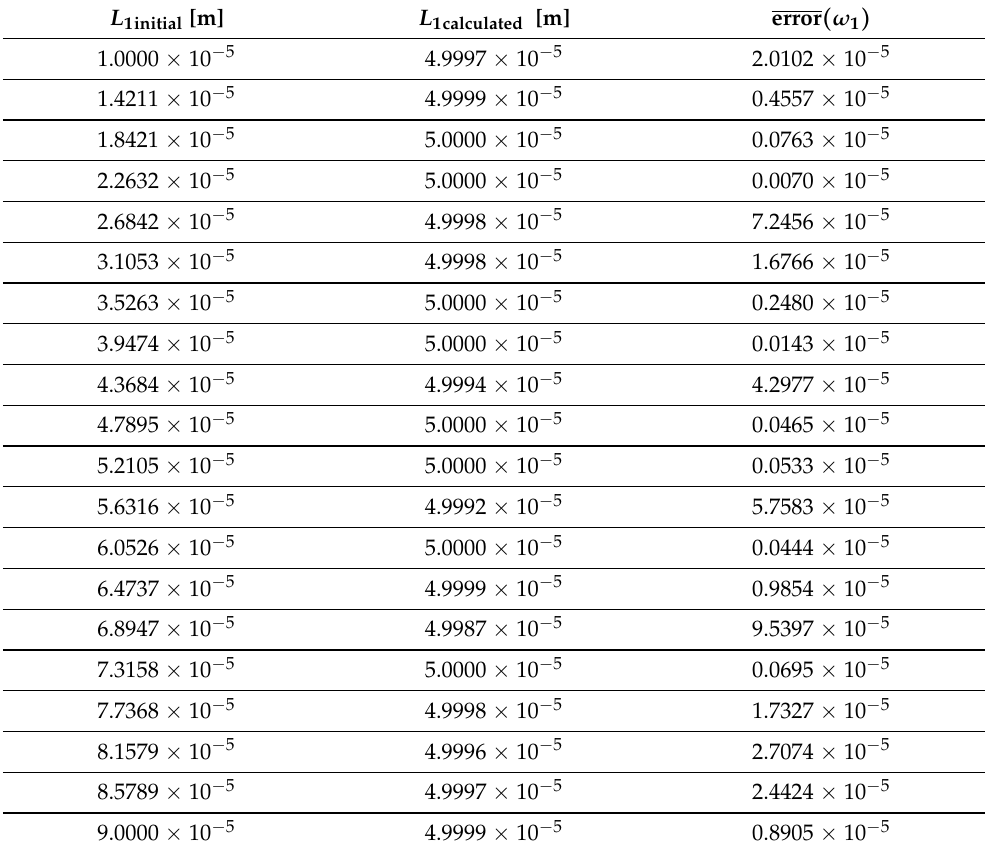
Table 4. Results for case (1.1.3).